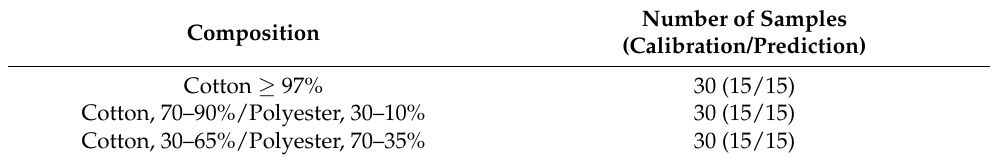
Table 9. Textile samples analyzed in study No.